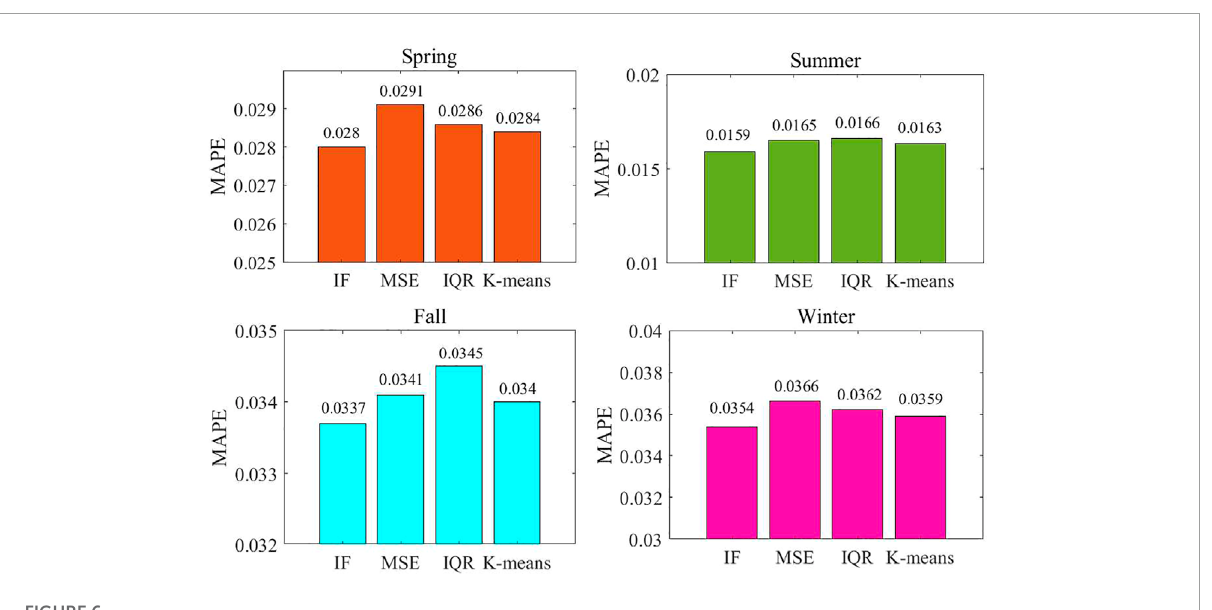
FIGURE 6 The MAPE results for different outlier detection methods.